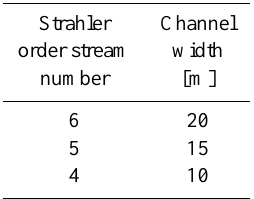
Table 2. The channel width corresponding to Strahler stream order number